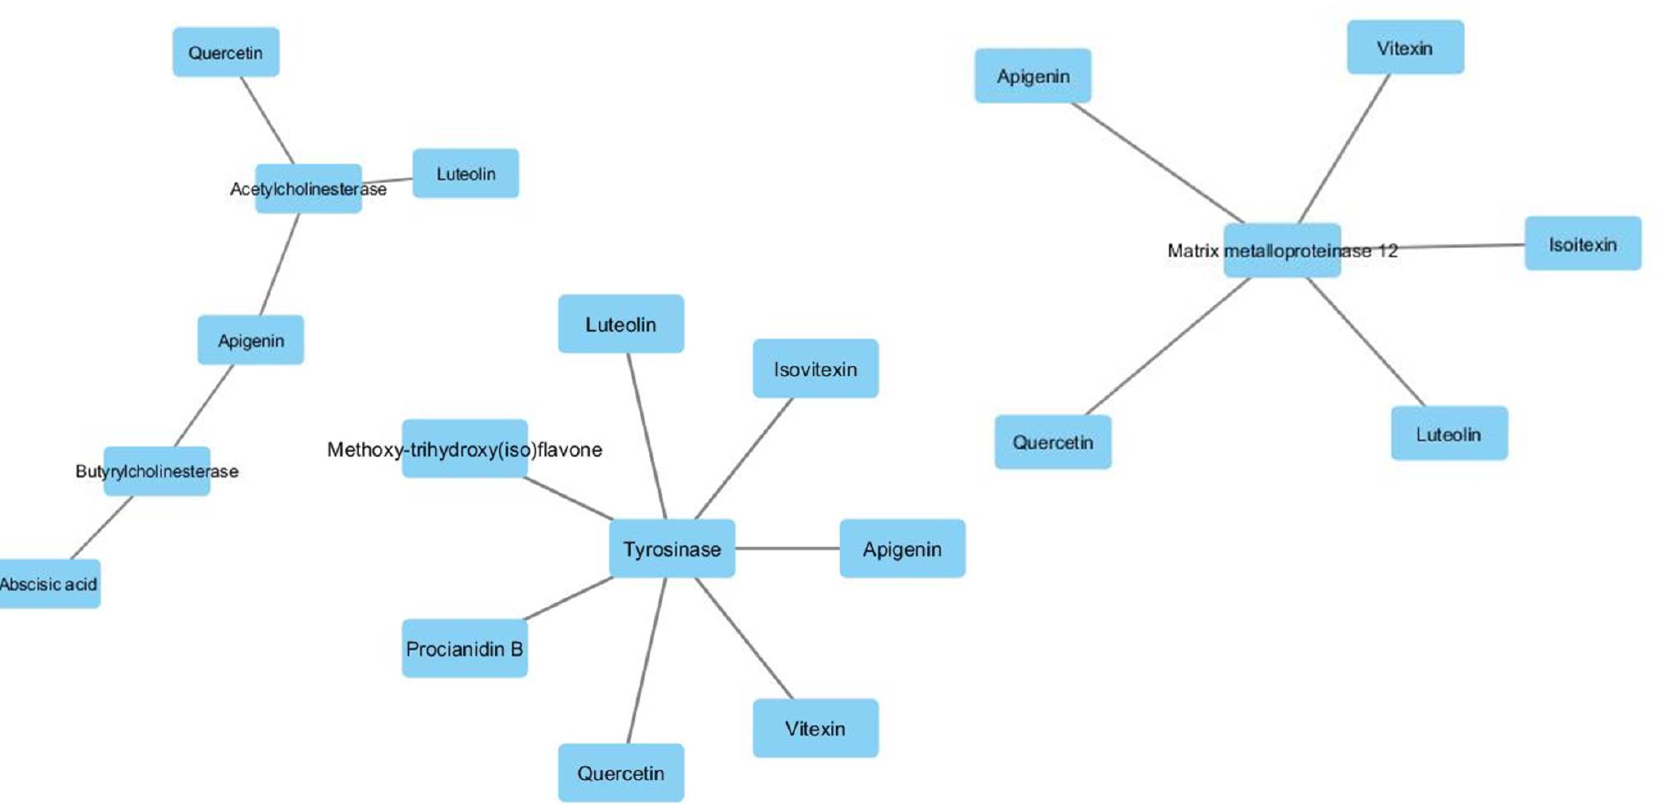
Figure 6. Components-targets analysis highlighting the putative interactions of luteolin, apigenin, vitexin, isovitexin, quercetin, procyanidin B and methoxy-trihydroxy(iso)flavone with tyrosinase, cholinesterases and metalloproteinase-12.